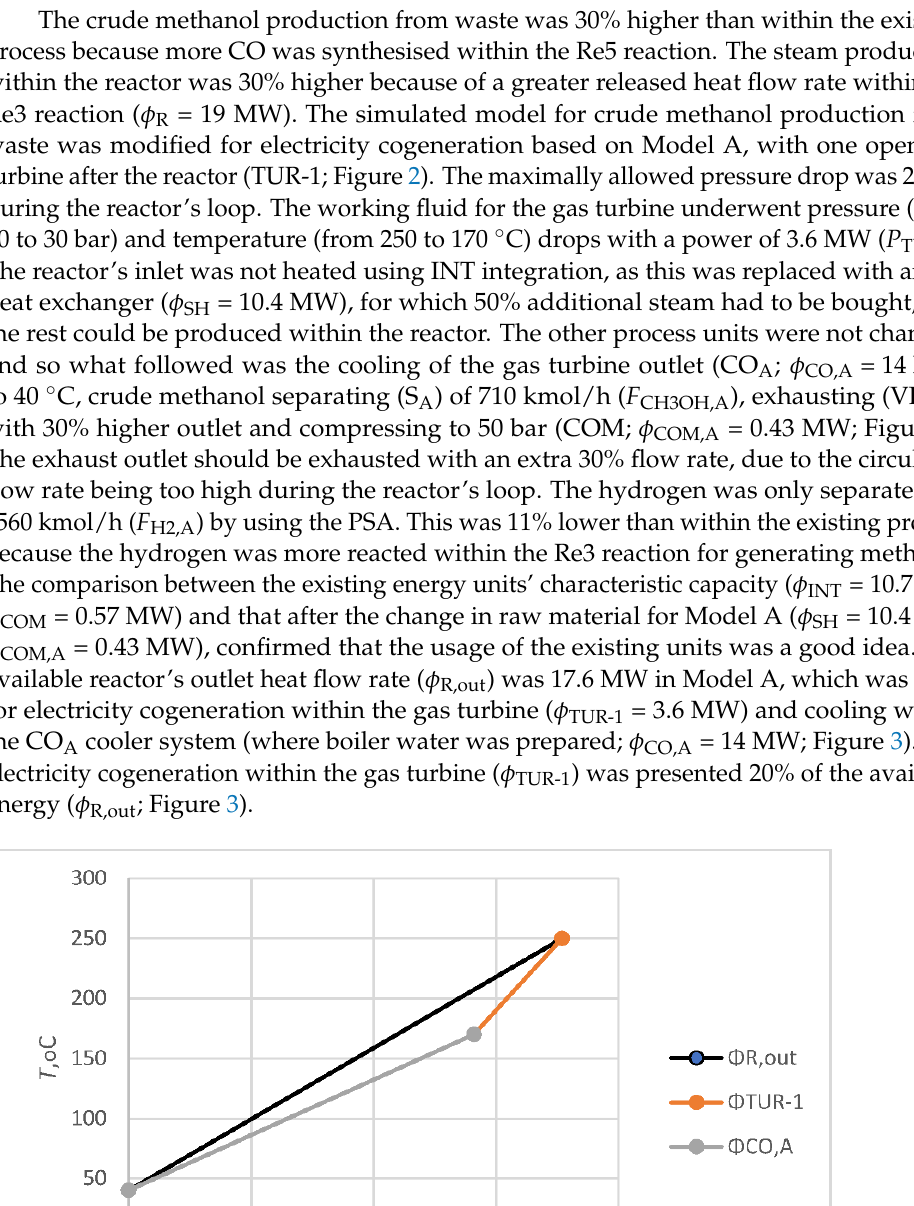
Figure 4. The usage of electricity cogenerations with two gas turbines, including cooling. The maximum available electricity cogeneration within the first turbine ( P el-TUR-1 ; us- ing Equations (1) and (2)) could be determined previously from the product`s thermody- namic using the heat capacity of the outlet flow rate ( FCp TUR = 0.045 MW/K) and the num- ber of components going into the outlet ( FCp TUR,com ; com= CO, CO 2 , H 2 , CH 4 , CH 3 OH; FCp- TUR,CO = 0.005, FCp TUR,CO2 = 0.007, FCp TUR,H2 = 0.016, FCp TUR,CH3OH = 0.012, FCp TUR,CH4 = 0.005 MW/K), and the temperature difference (Δ T TUR-1 ) between the inlet ( T TUR,in = 250 °C) and outlet ( T TUR,out = 170 °C) gas turbines (Equations (5)–(7)). P el-TUR-1 = P TUR-1 × η el = 3.6 × 0.7 = 2.52 MW